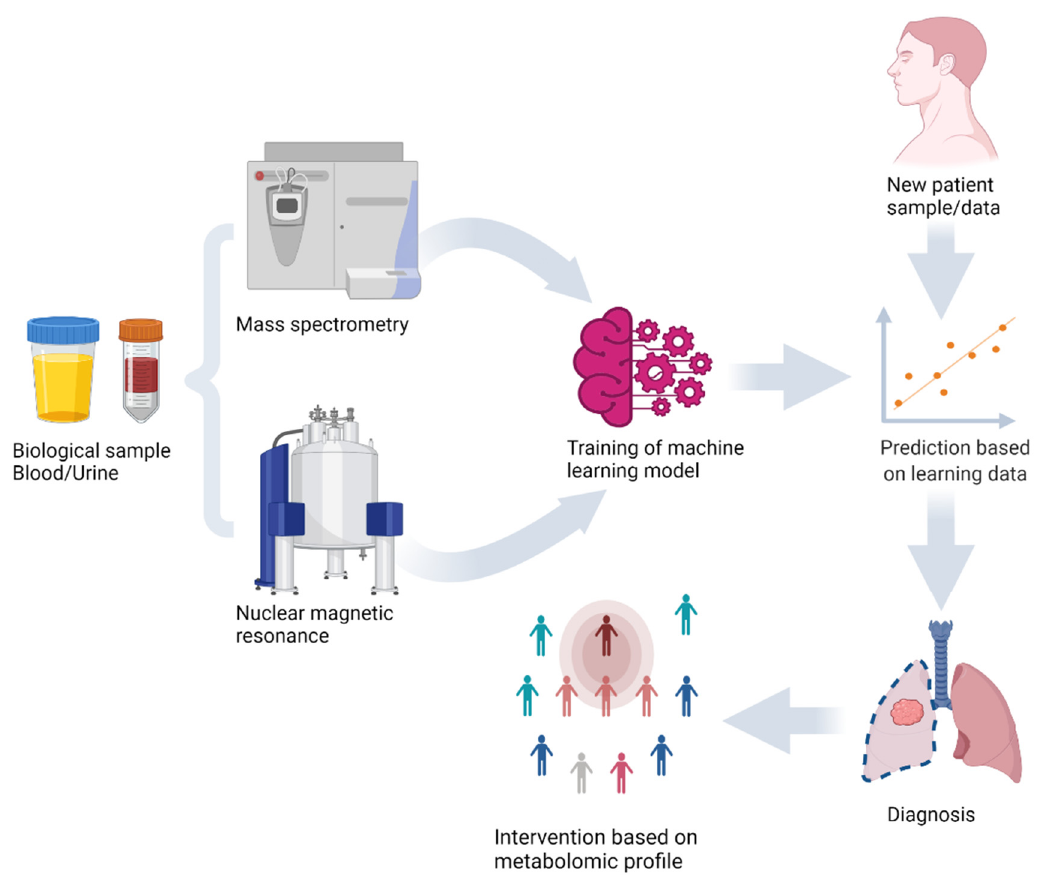
Figure 1. Machine learning model training and prediction of new sample using metabolomics analysis of biological samples with mass spectrometry and nuclear magnetic resonance.